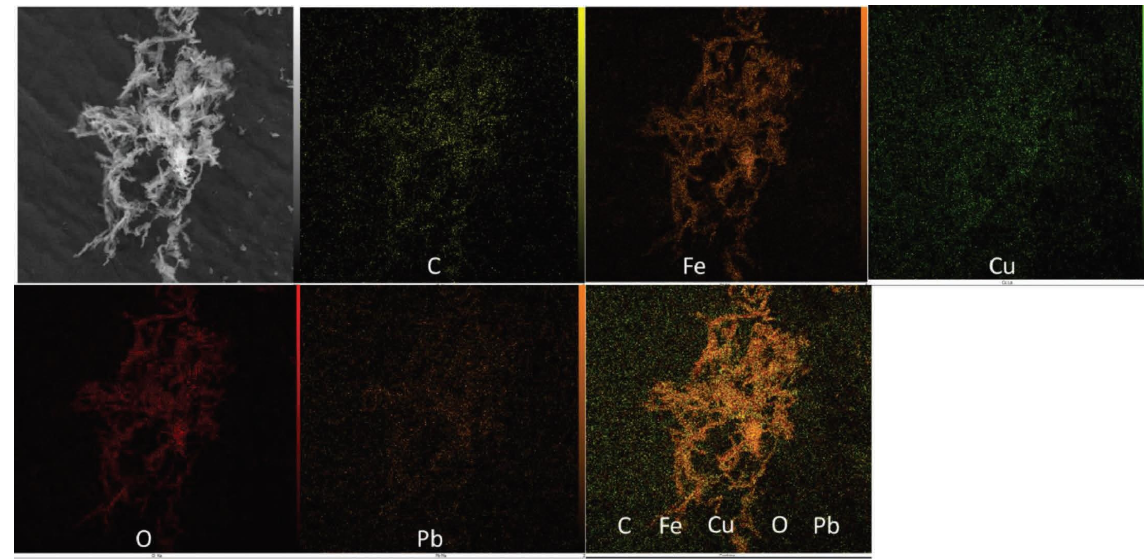
Figure 2: Elemental mapping of Cu-BTC@Fe